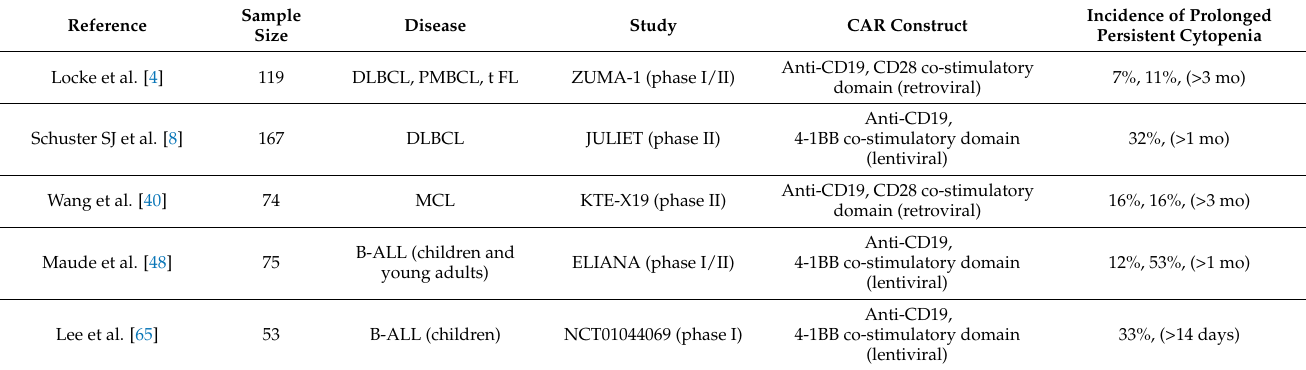
Table 1. Incidence of Prolonged Cytopenia in a Sample of CAR T Primary Studies.